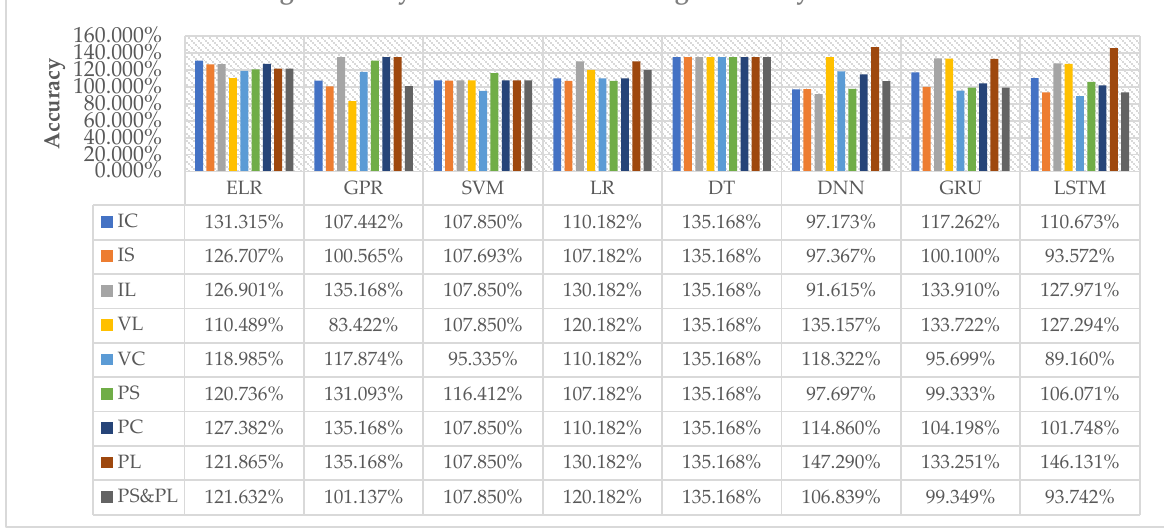
Figure 12. Average accuracy of the estimated equivalent series resistance ( ESR ) using fast Fourier transform (FFT) analysis and high-pass filter 2 .